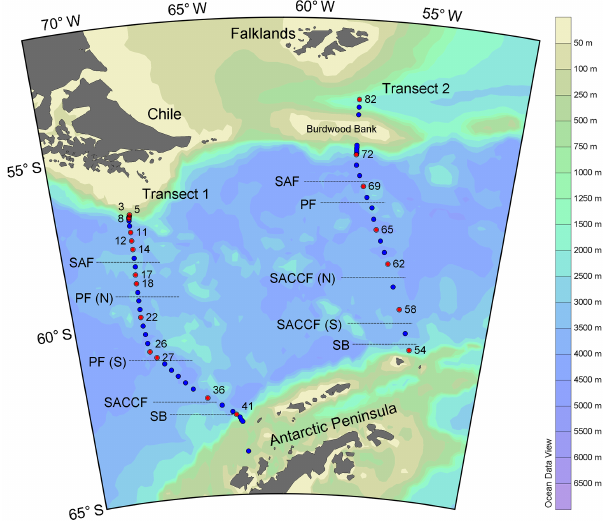
Figure 1. JC31 cruise track, showing Transect 1 (Chile to Antarc- tica) and Transect 2 (Antarctica to Falklands). Blue and red circles indicate sampling stations. Red circles are numbered and indicate stations where calcification rates were also measured. The loca- tions of the following fronts are shown on each transect: Subantarc- tic Front (SAF), Polar Front (PF), Southern Antarctic Circumpolar Current Front (SACCF) and southern boundary of the ACC (SB). Where two possible locations or two branches of a front were ob- served, these are denoted with a northern (N) or southern (S)